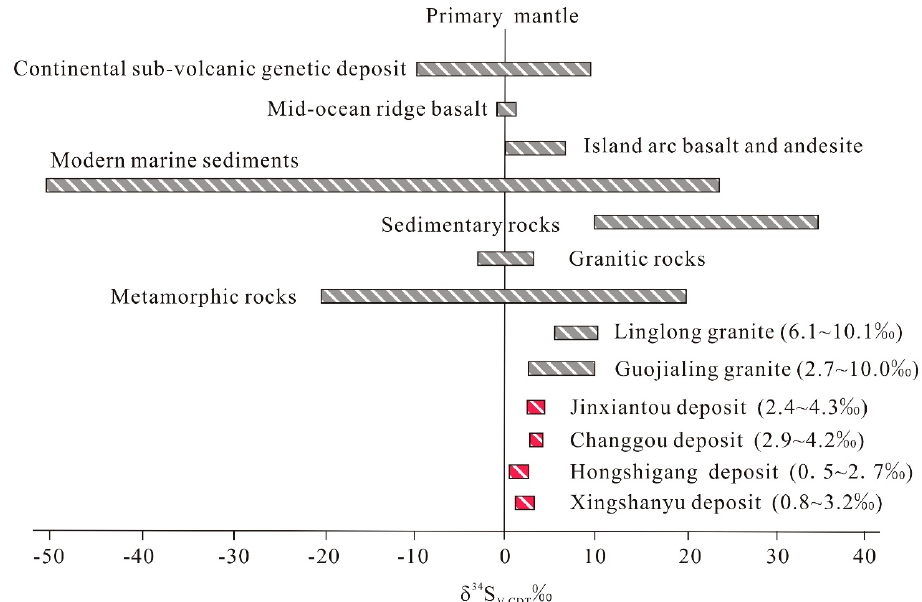
Figure 9. δ 34 S values of quartz from the Qibaoshan polymetallic ore field compared with the values